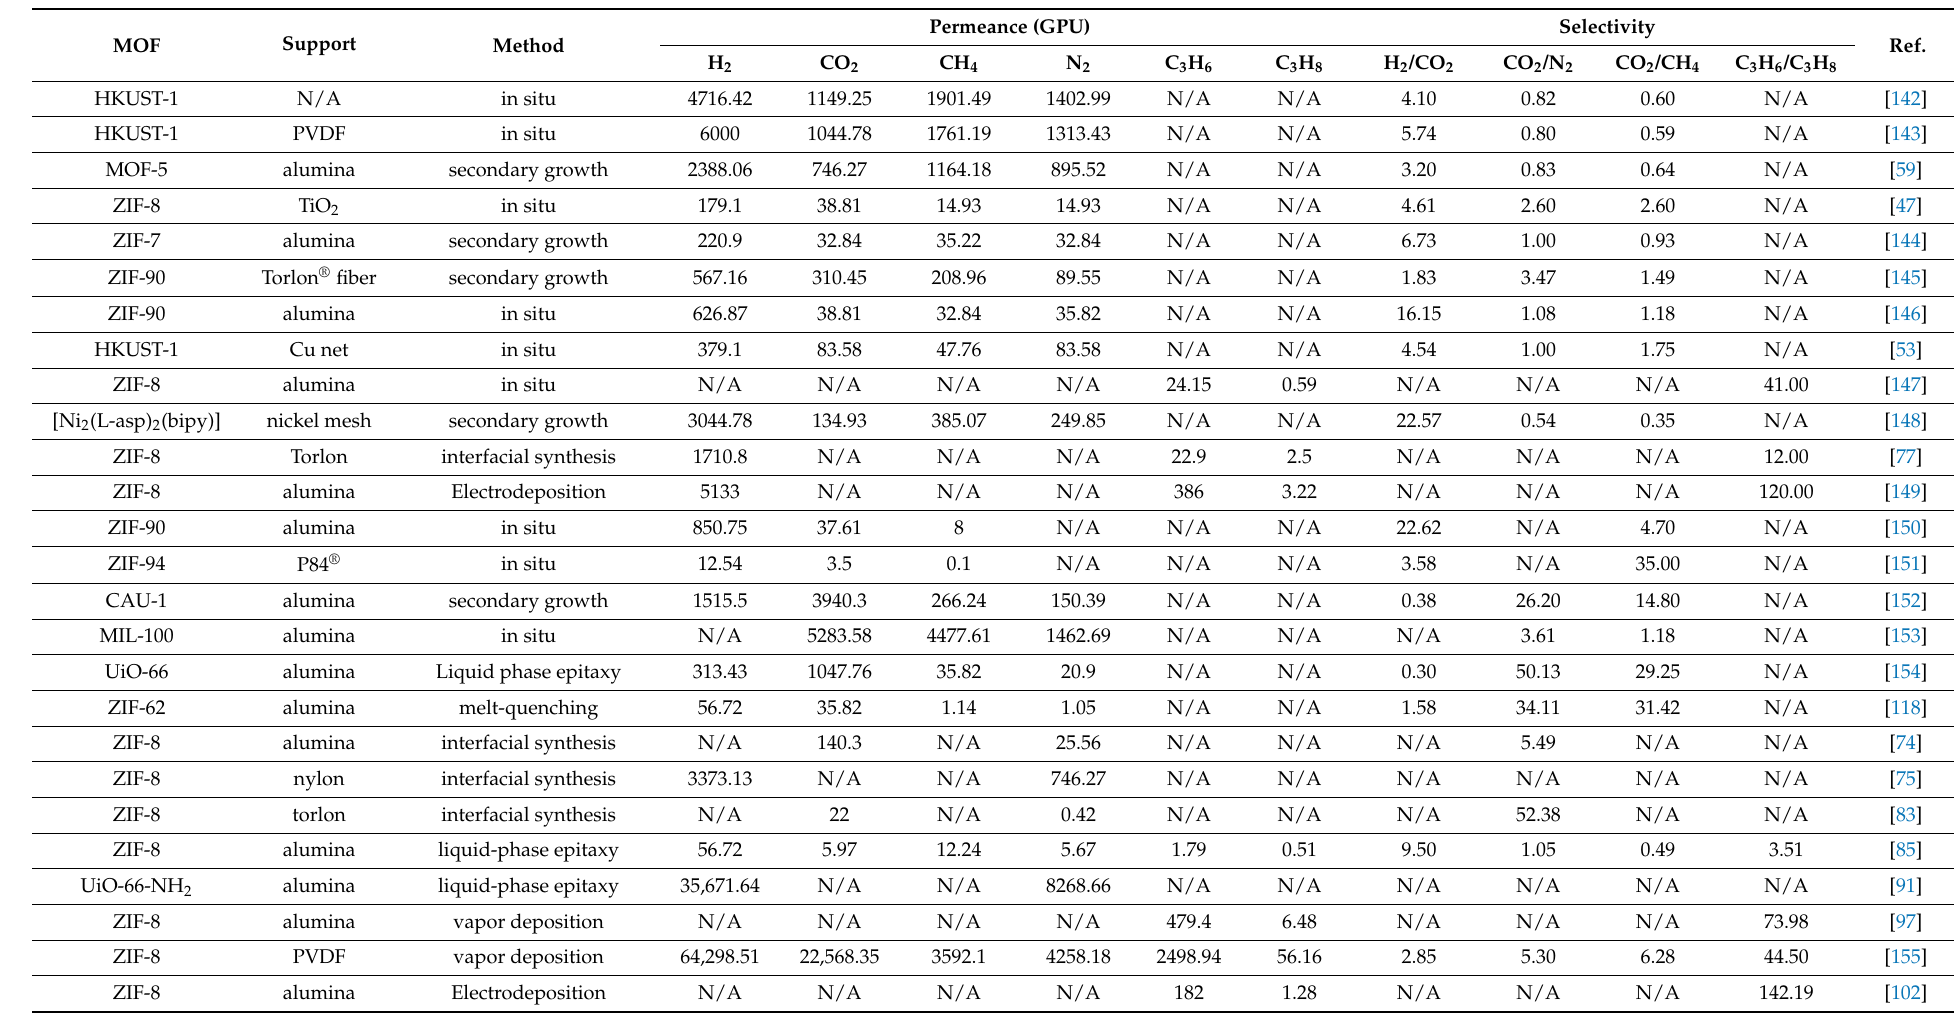
Table 2. Continuous MOF membranes for gas